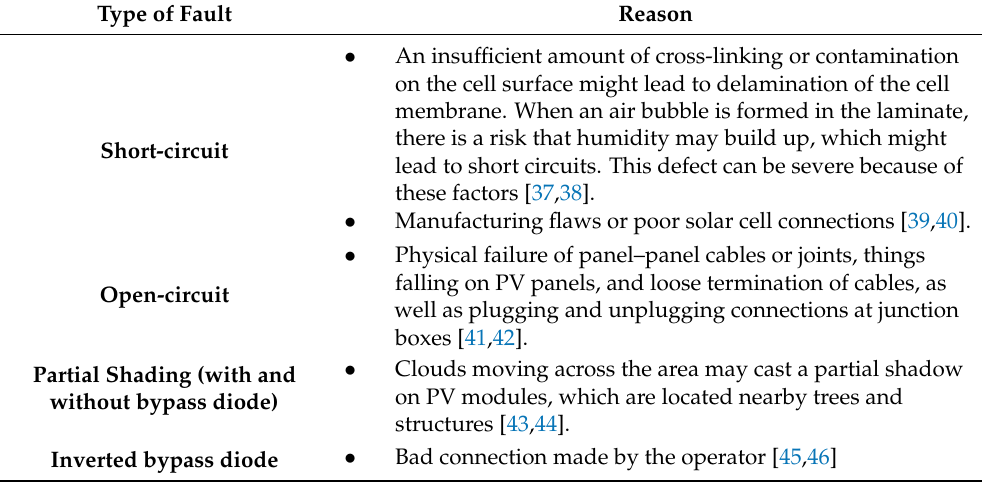
Table 2. Various types of faults in PV